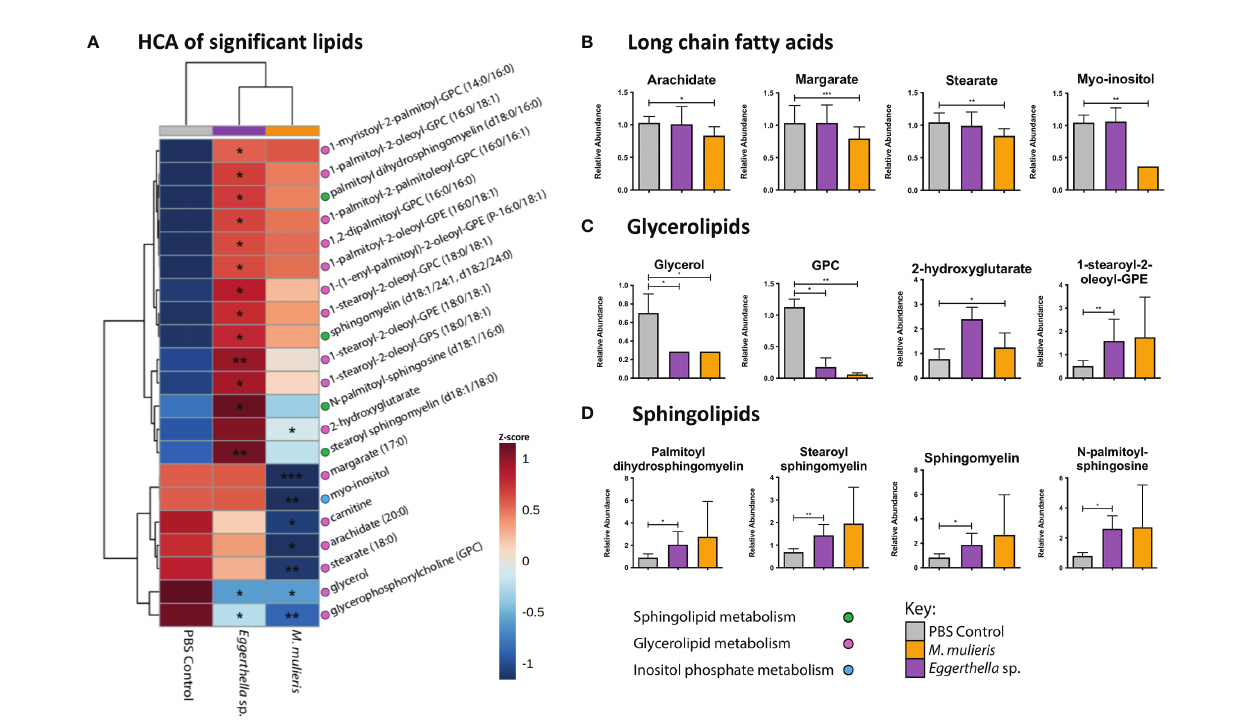
FIGURE 5 | Eggerthella sp. signi fi cantly altered the abundance of more lipids than M. mulieris. (A) Hierarchical clustering analysis (HCA) of differentially abundant lipids ( p <0.05) determined by Students t-tests with Welch ’ s correction of Eggerthella sp. MVA1 and M. mulieris UPII-28I infection compared to the PBS mock- infected control. HCA was performed using Euclidean distance measures and average linkage clustering algorithms. Relative abundance graphs of signi fi cant lipids classi fi ed into long-chain fatty acids (B) , glycerolipids (C) and sphingolipids (D) . The brackets after the lipids indicate how many carbons and how many double bonds there are in the structure of the lipid. The slash between numbers separates the information about the two hydrocarbon chains of the lipid, whilst the P- pre fi x indicates a neutral plasmalogen species and the d for sphingomyelins indicates a 1,3 dihydroxy chain. Signi fi cant differences between the bacteria and PBS mock- infected controls. *, p <0.05; **, p <0.01; ***, p